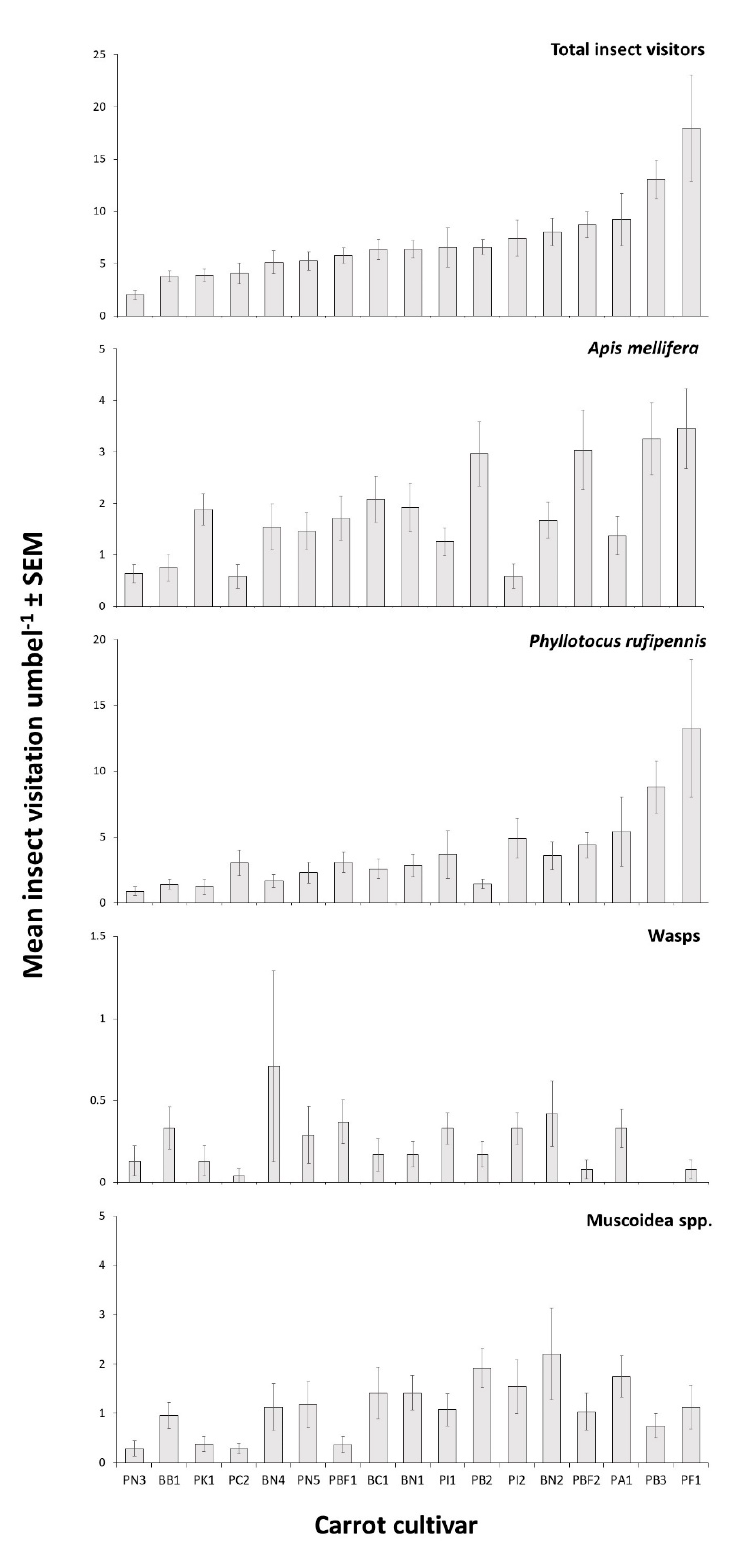
Figure 1. Mean ( ± SEM) total insect visitors, Apis mellifera, Phyllotocus rufipennis (nectar scarabs), wasp, and muscoid fly. Visitation per 5 min to 17 hybrid CMS carrot cultivars in field trial A between January and February (n = 24 umbels per cultivar).